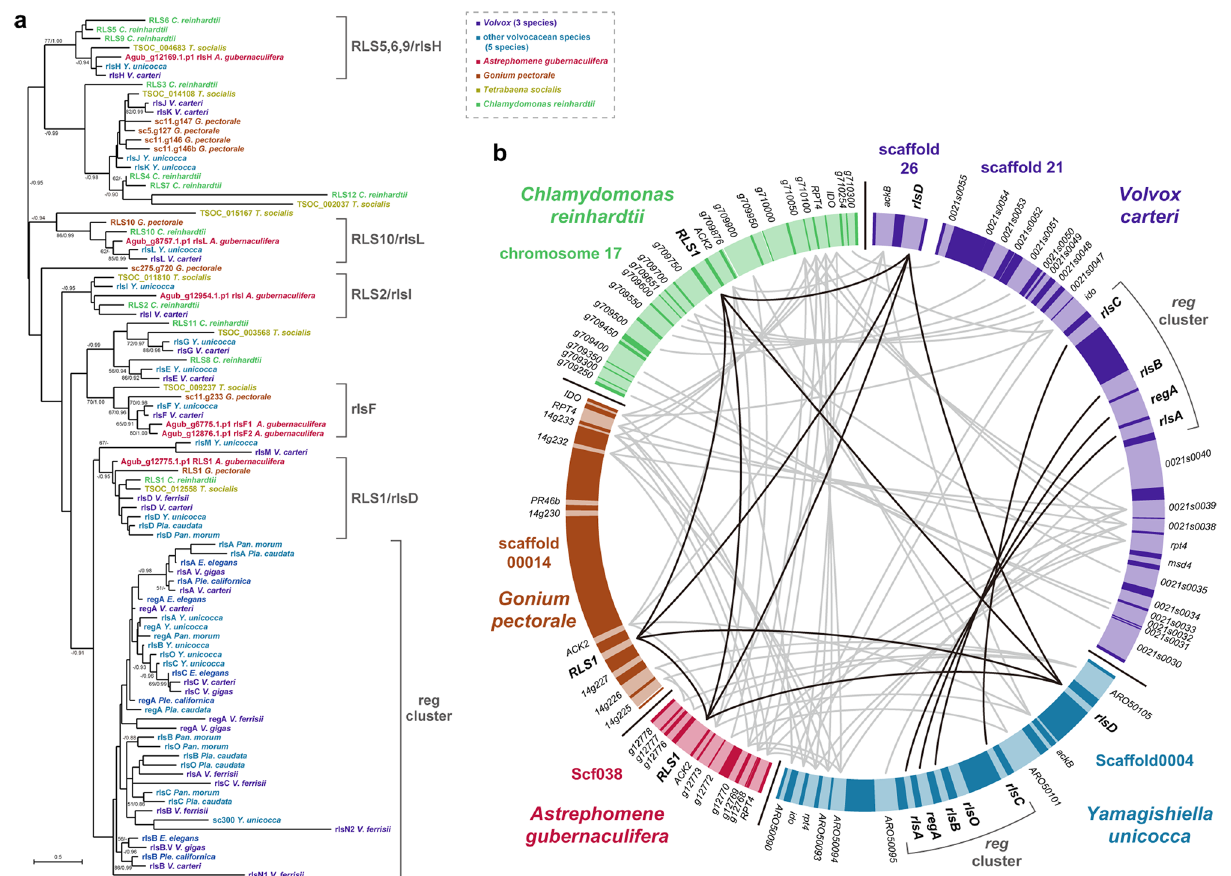
Figure 2. Analysis of RLS1 / rlsD orthologs and VARL genes in volvocine green algae. ( a ) Maximum-likelihood phylogenetic tree of VARL domain containing protein among volvocine algae. The 87 amino acid positions of 6 VARL genes in Astrephomene gubernaculifera as well as all known VARL genes identified in previous studies 10,29 were subjected to maximum-likelihood analysis and Bayesian interference (LG + I + G model). The bootstrap values from maximum-likelihood (≥ 50%, left) and posterior probabilities in Bayesian interference (≥ 0.90, right) are shown at branches. The colors indicate species according to the color key at the upper right. ( b ) Synteny of Chlamydomonas reinhardtii , Gonium pectorale , A . gubernaculifera , Yamagishiella unicocca and Volvox carteri . The synteny of RLS1 / rlsD orthologs and reg cluster genes is indicated with black lines, and the synteny of other genes are indicated with grey lines based on BLASTP search (Supplementary